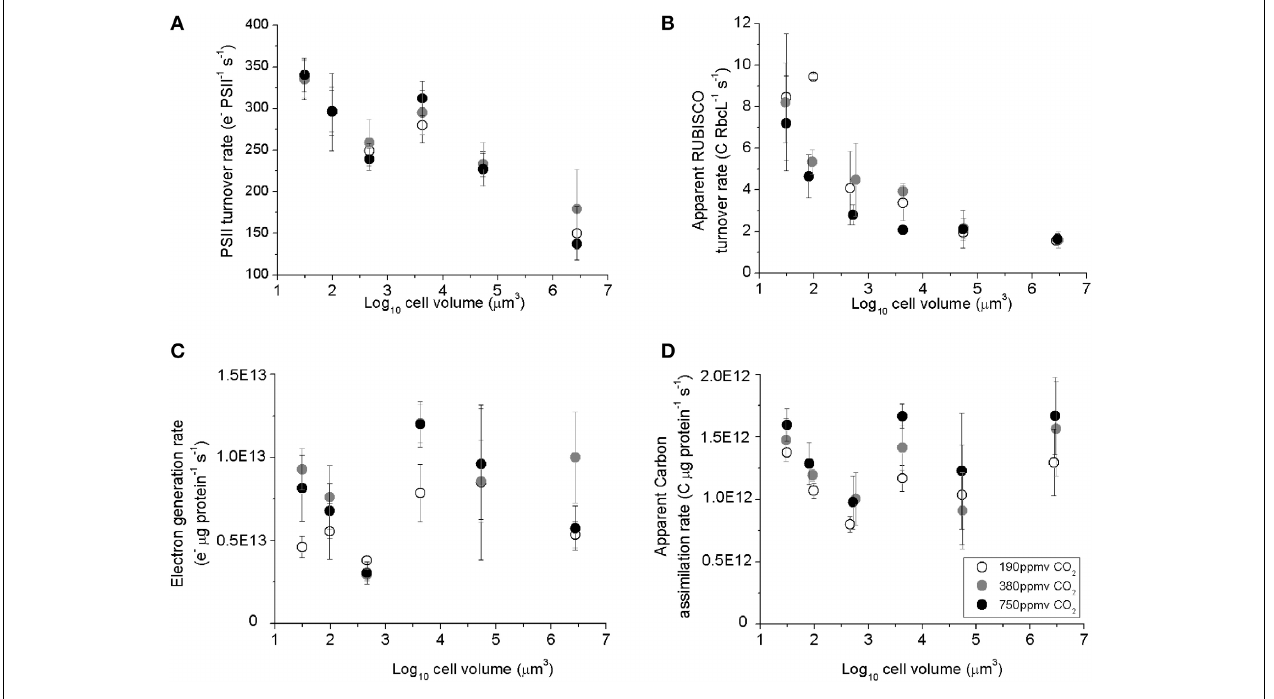
FIGURE 3 | (A) The Photosystem II electron turnover rate, (B) apparent carbon assimilation rate per RUBISCO catalytic site, (C) electron generation rate per total protein, and (D) apparent carbon assimilation rate per total